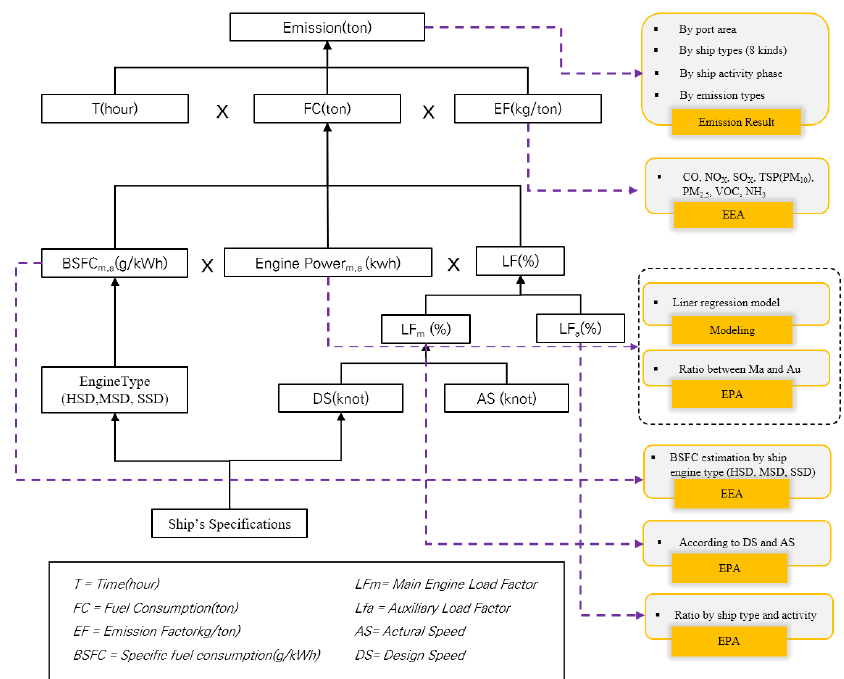
Figure 4. The process of the calculation